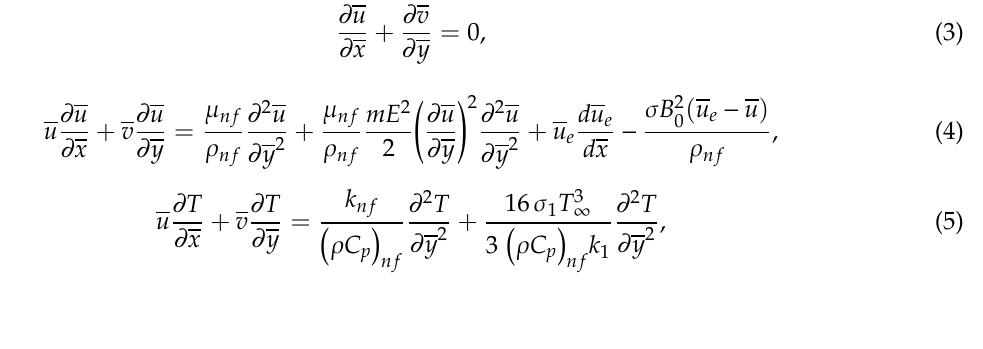
Figure 1. Schematic diagram of the present problem: ( a ) shrinking sheet ( u w < 0 ) ; ( b ) stretching sheet ( u w > 0 ) .